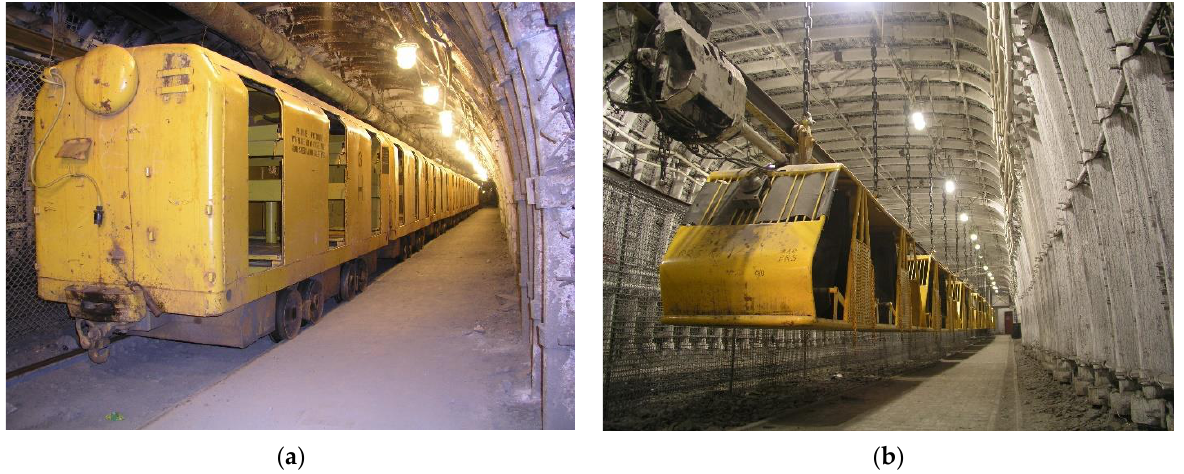
Figure 6. Underground transport means used in LW Bogdanka S.A.: an underground railway passenger carriage ( a ) and overhead passenger cabin/rail ( b ). Source: photos provided by